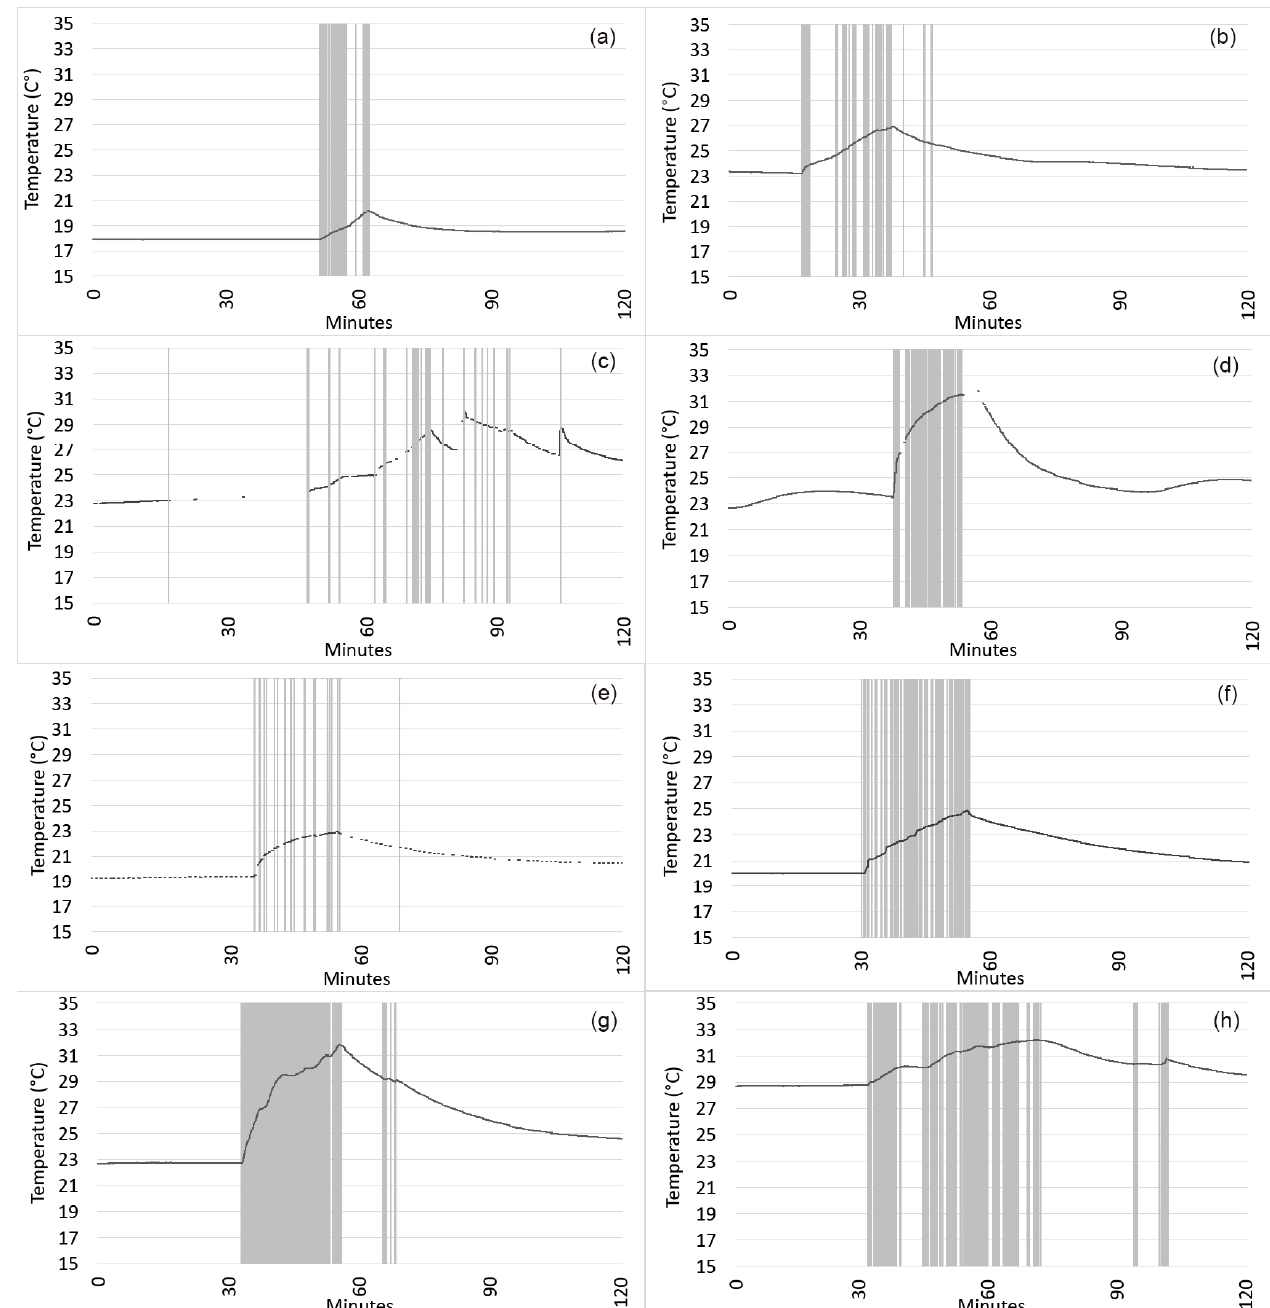
Figure 1. One graph from each participant to display the beacon sensor data for longitudinally collected temperature (black line) and motion, represented by the grey vertical lines, for one diary-logged period for magnifier use, along with additional time shown immediately preceding and subsequent to the magnifier usage. ( a ) Subject 1 reported using the magnifier for 10 min, when the beacon sensor recorded 109 instances of motion and a total temperature increase of 2.25 ° C. ( b ) Subject 2 reported using the magnifier for 30 min, when the beacon sensor recorded 209 instances of motion and a total temperature increase of 3.7 ° C. ( c ) Subject 3 reported using the magnifier for 30 min, when the beacon sensor recorded 196 instances of motion and a total temperature increase of 4.6 ° C. ( d ) Subject 4 reported using the magnifier for 20 min, when the beacon sensor recorded 230 instances of motion and a total temperature increase of 8.3 ° C. ( e ) Subject 5 reported